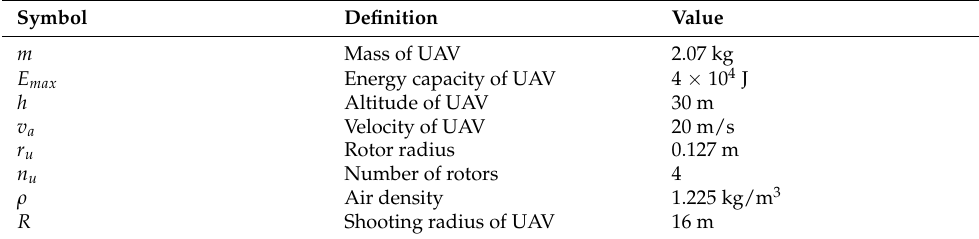
Table 2. Simulation